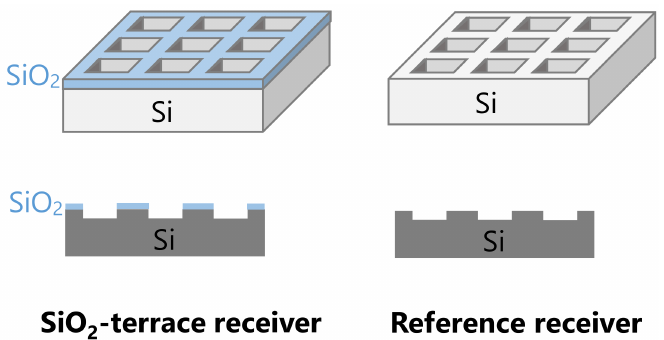
Figure 4. Schematic bird’s-eye views and cross-sectional views of the SiO 2 -terrace receiver and the reference Si-only